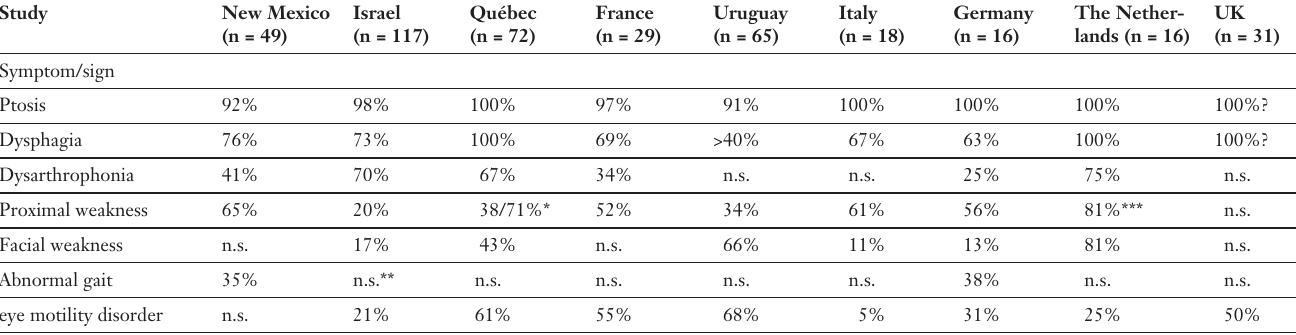
Frequency of clinical signs of OPMD according to different studies [5, 6, 12, 13, 18, 19, 92–95]; (modified from [13]). Study New Mexico